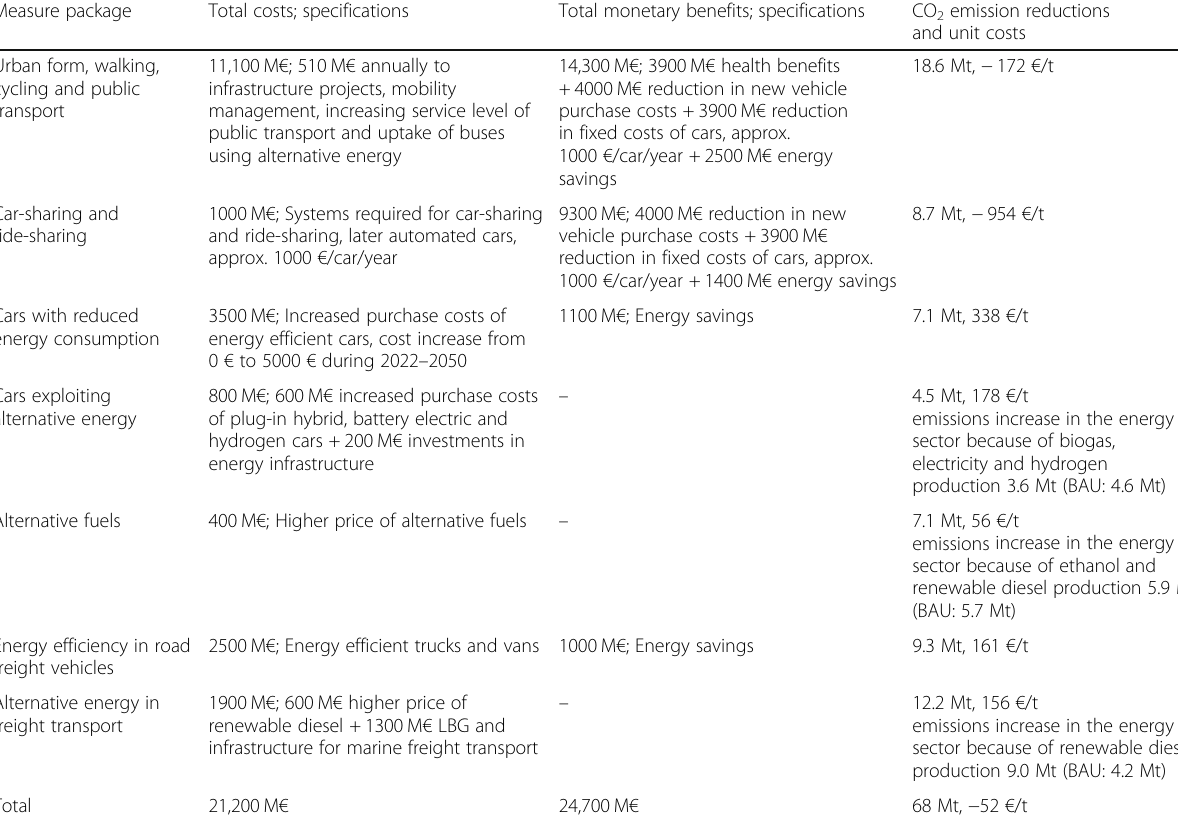
Table 5 Costs and benefits from the different measure packages in the recommendation scenario Measure